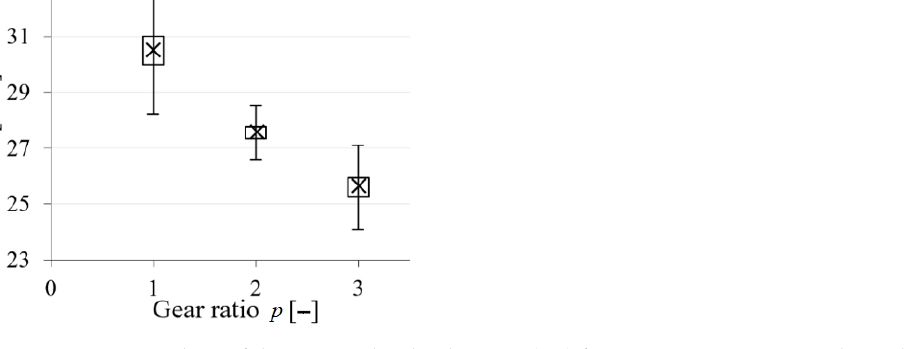
Figure 9. Average values of the area under the diagram ( SA ) for measurement tests s2, k1 and p1-3 for the posterior part of the deltoid muscle (B); error bars are ± standard deviation, rectangles are ± standard error. Table 2. The average values and the statistical data of the area under the diagram ( SA ) for the individual propulsion cycles; x —arithmetic mean, σ —standard deviation of the arithmetic mean, σ x —standard error, p val —test probability for the Anderson–Darling test; muscle markings: Deltoid muscle anterior (A) and posterior (B), Triceps brachii (C), Extensor carpi radialis longus (D); markings of the angles of the erection of the wheelchair: k1 = 0 ◦ , k2 = 1.5 ◦ and k1 = 5.4 ◦ ; markings of experiment series: s1, s2 and s3; markings of the propulsion system gear ratios: p1 = 1.96, p2 = 1 and p3 = 0.51. s1